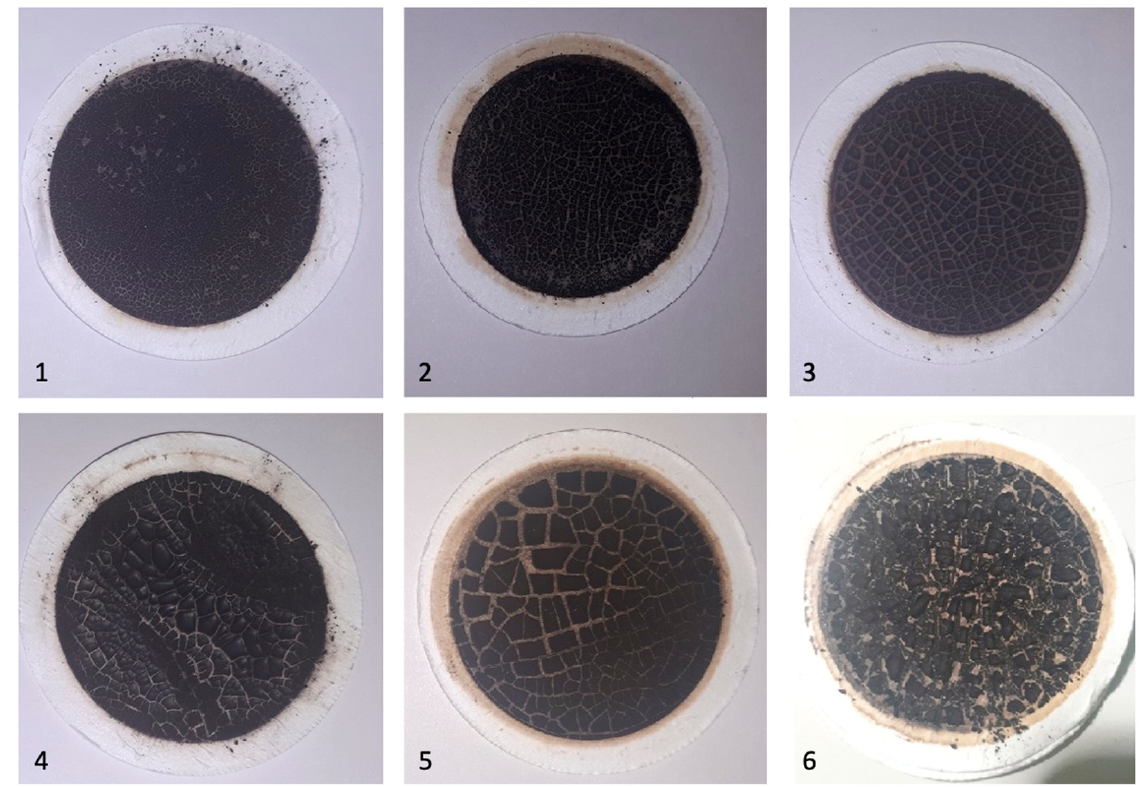
Figure 3. The obtained sediments (sludge) after deasphaltation and filtration for fuel samples 1–6. It could be noted that the intensity of sediments (sludges) on the filter varied symbati- cally with a decrease in the formed TSP sediment content.